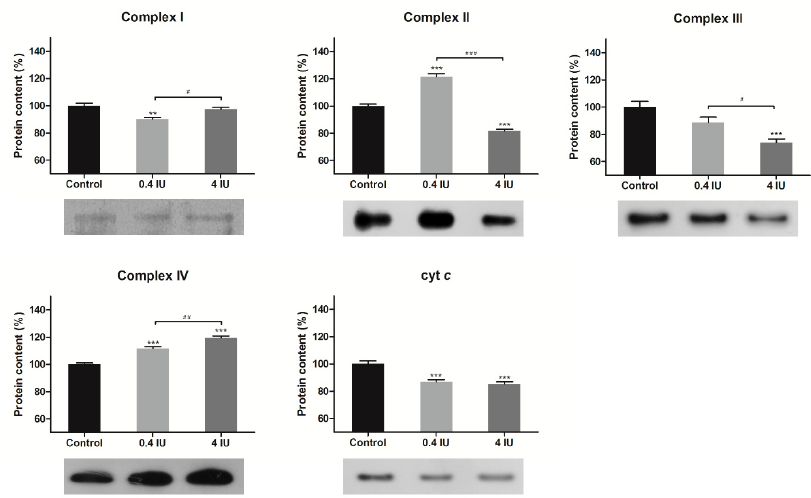
Figure 3. Effects of chronic insulin treatment on the expression of ETC complexes and cyt c in MEF. Protein content is expressed relative to controls, which were standardized to 100%. Mean ± SEM values are averages of three independent experiments performed in triplicate (pooled from six animals in each group). A representative blot is shown. Volume is the sum of all pixel intensities within a band (1 pixel = 0.007744 mm 2 ). * compared to control: ** p ≤ 0.01, *** p ≤ 0.001; # 0.4 IU vs. 4 IU: # p ≤ 0.05; ## p ≤ 0.01; ### p ≤ 0.001.